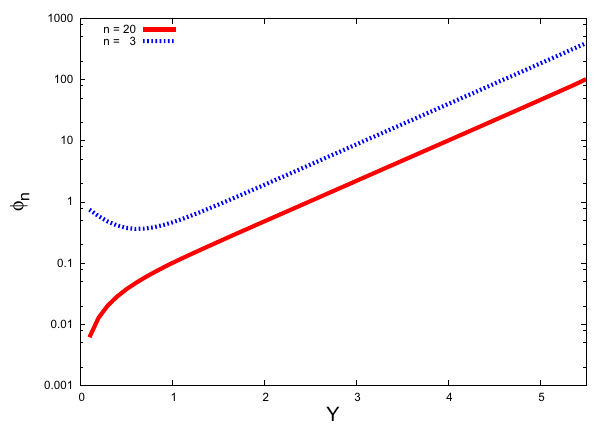
Fig. 5 The growth of the BFKL Green’s function with Y Fig. 6 The growth of the vector (cid:4) φ with Y for a matrix size N = 50,